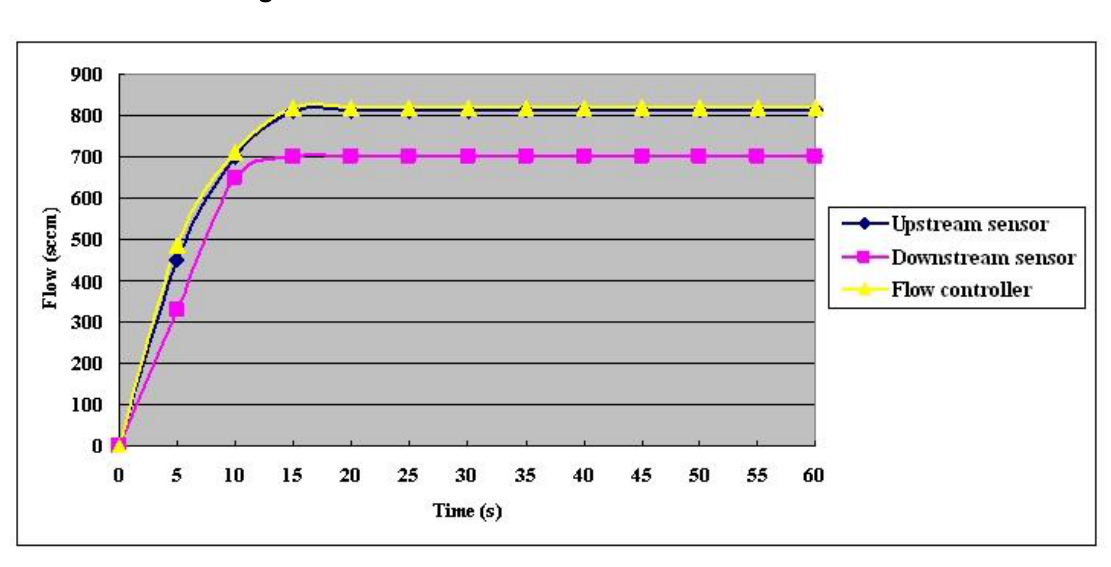
Figure 10. Constant current 25A test flow trend chart.